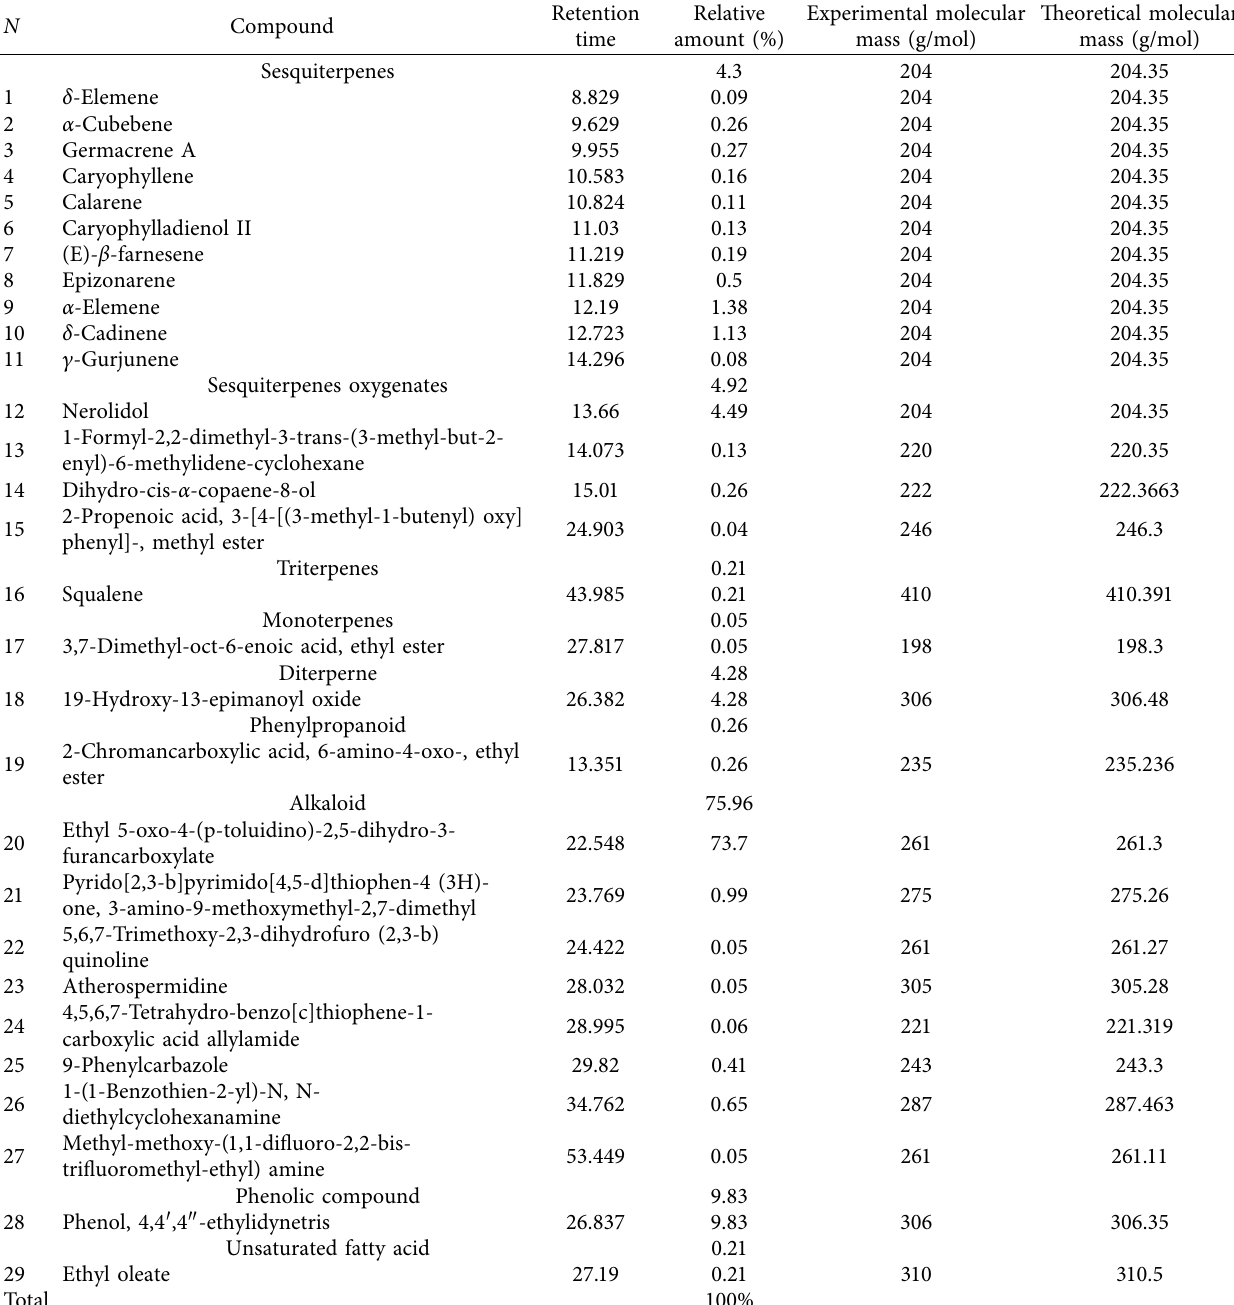
Table 3: Components identified by GC/MS in ethanolic extract from the bark of M. americana